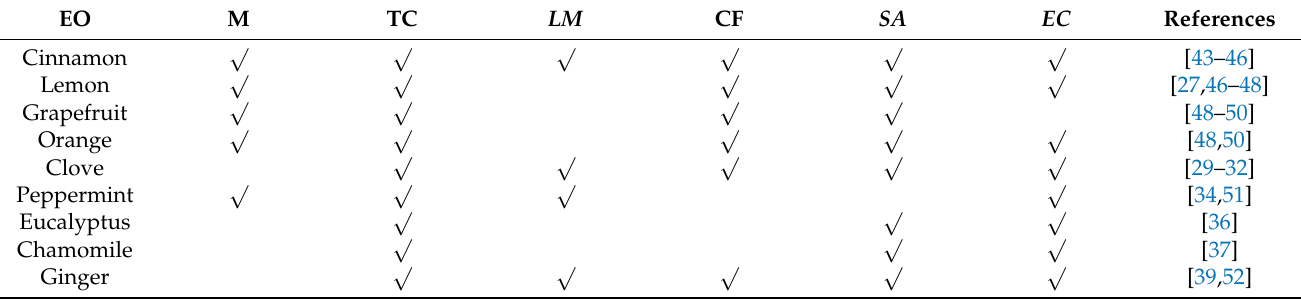
Table 2. Essential oils displaying antimicrobial properties against relevant microorganism categories and